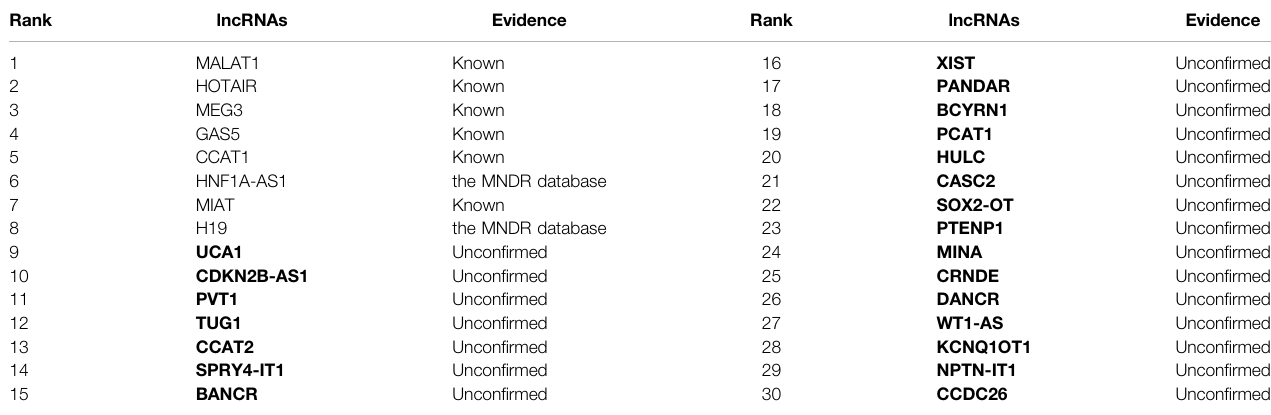
TABLE 4 | Inferred top 30 lncRNAs associated with LUAD.